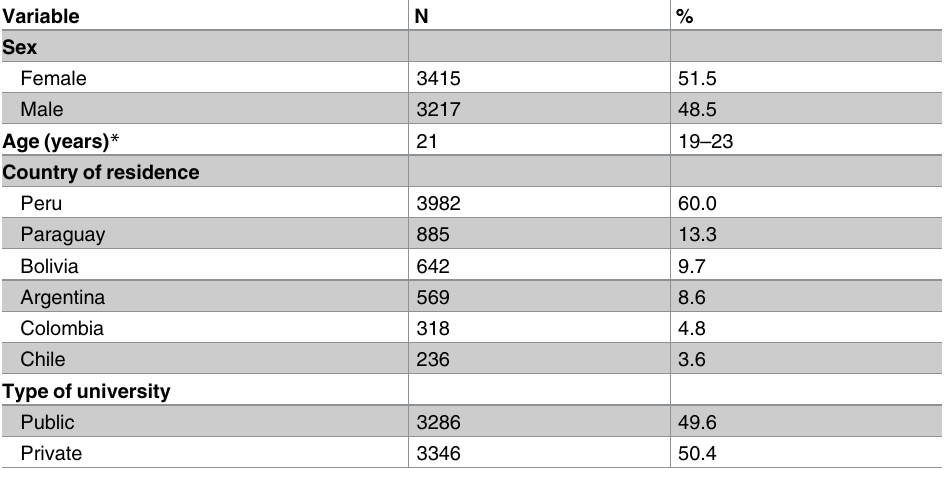
Table 1. Distribution and demographics of medical students from 6 Latin American